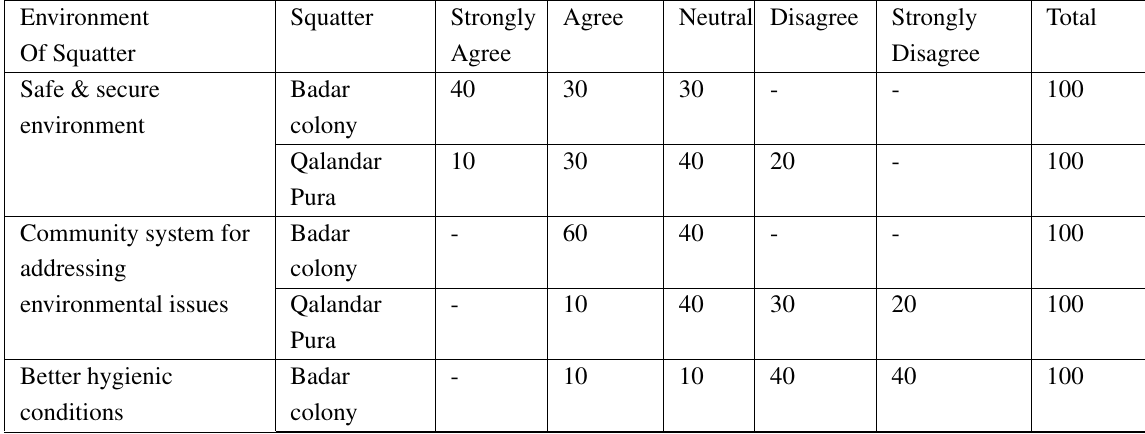
Table 3. Environment of Squatters, Source: